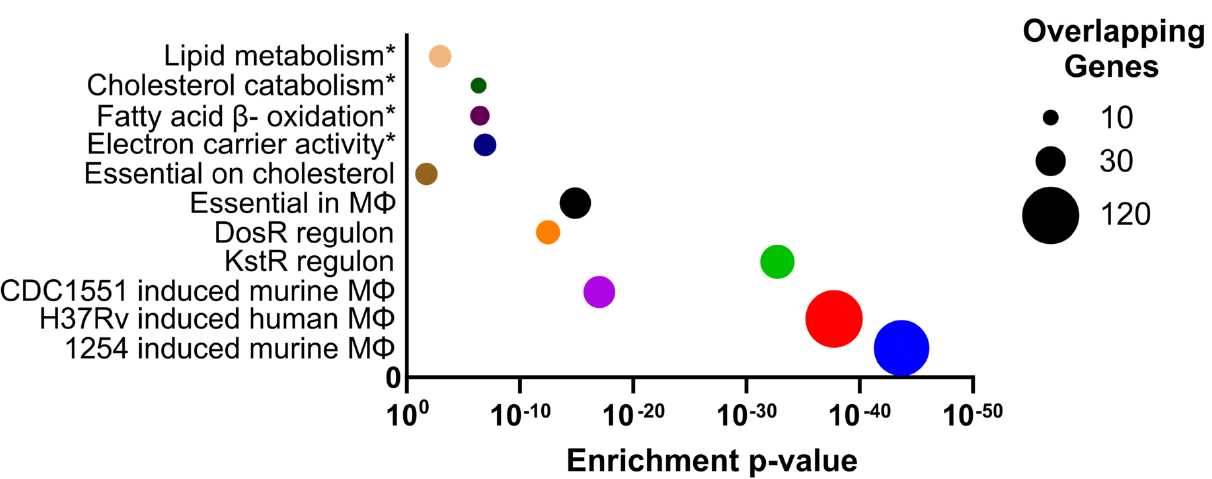
Figure 2. Features of the M. bovis BCG transcriptional response to the macrophage microenvironment highlighted by gene enrichment analyses of upregulated genes. Metabolic/respiratory pathways (marked with asterisks) identified from DAVID [22]; genes essential for growth on cholesterol [15], and for growth in macrophages [14]; regulons of DosR [23] and KstR [24]; and M. tuberculosis macrophage intracellular signatures with CDC1551[10], H37Rv [11], and 1254 [9].